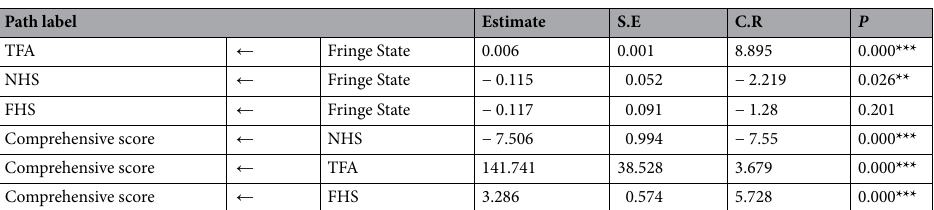
Table 4. Regression weights of the path analysis results about sand-burying of Phrynocephalus mystaceus. Note Estimate represents the regression coefficients for each path. The standard error of the estimate (Std. Error), t value and probability (P) were estimated using the path analysis in Amos (v.24.0). Significance levels: * P < 0.05, ** P < 0.01, *** P < 0.001.